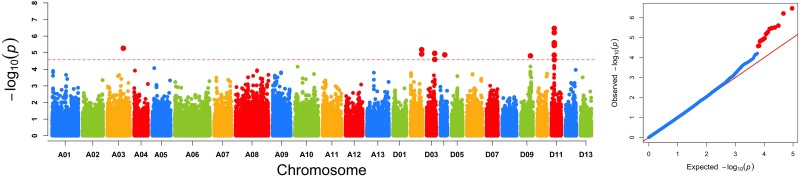
Genome-wide association scan of FL. (A) Manhattan plot of FL using the best linear unbiased prediction of FL value. The red dashed horizontal line represents the significance threshold (P < 2.5 × 10-5). (B) Quantile–quantile plots of FL.